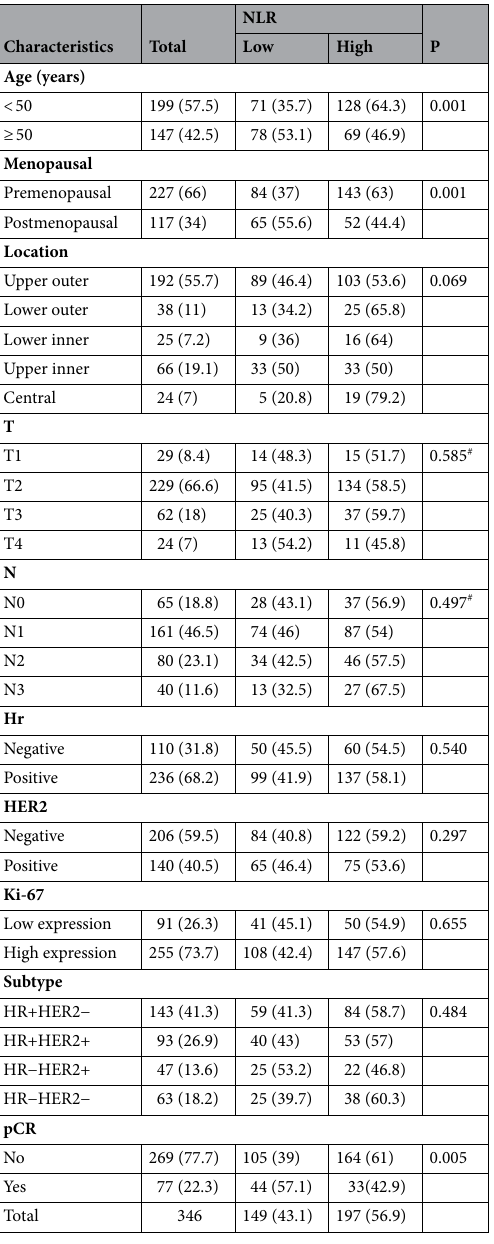
Table 1. Baseline patient characteristics (%). HR hormone receptor, HER2 human epidermal growth factor receptor-2, pCR pathologic complete response, NLR neutrophil–lymphocyte ratio, + positive, − negative, # Mann–Whitney U test